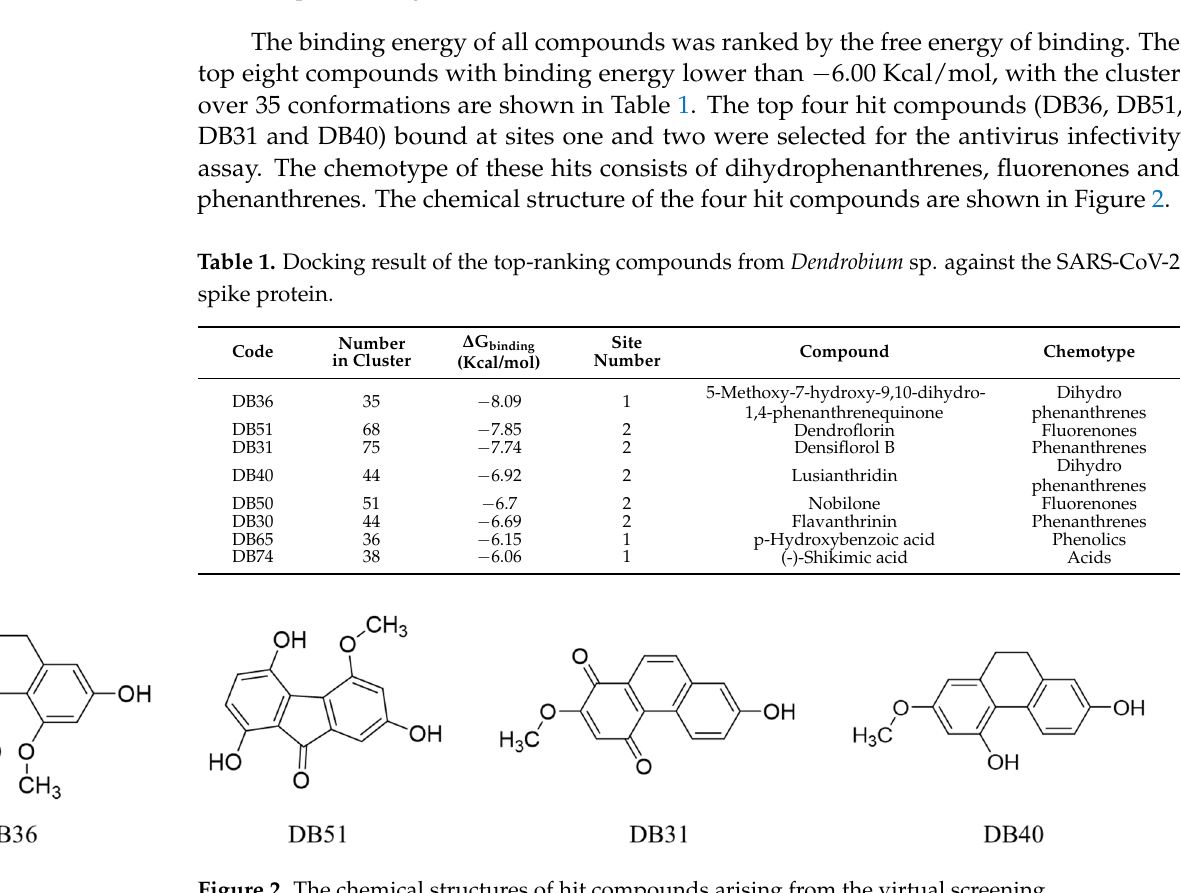
Figure 2. The chemical structures of hit compounds arising from the virtual screening .